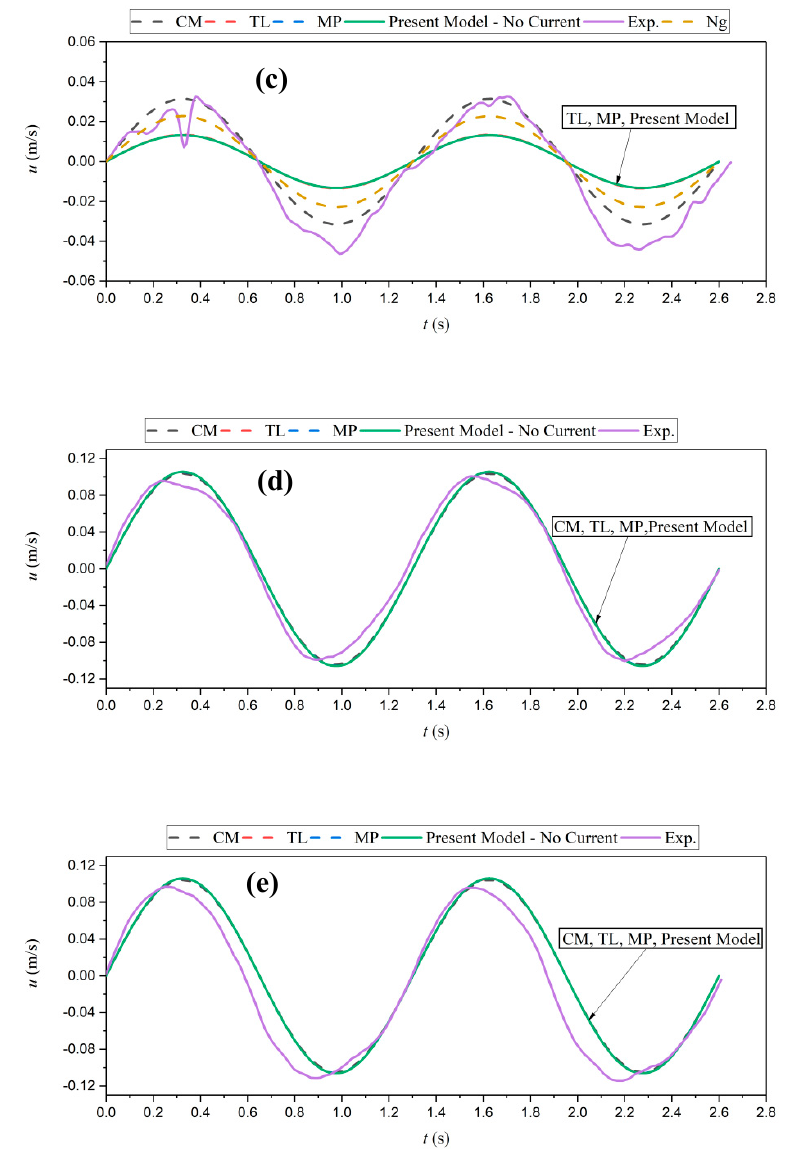
Figure 13. Time series of velocity for T = 1.3 s, H = 0.05 m, W = 160%; ( a ) 0.02 m; ( b ) 0.05 m; ( c ) 0.085 m; ( d ) 0.12 m; ( e ) 0.135 m above the rigid bed.